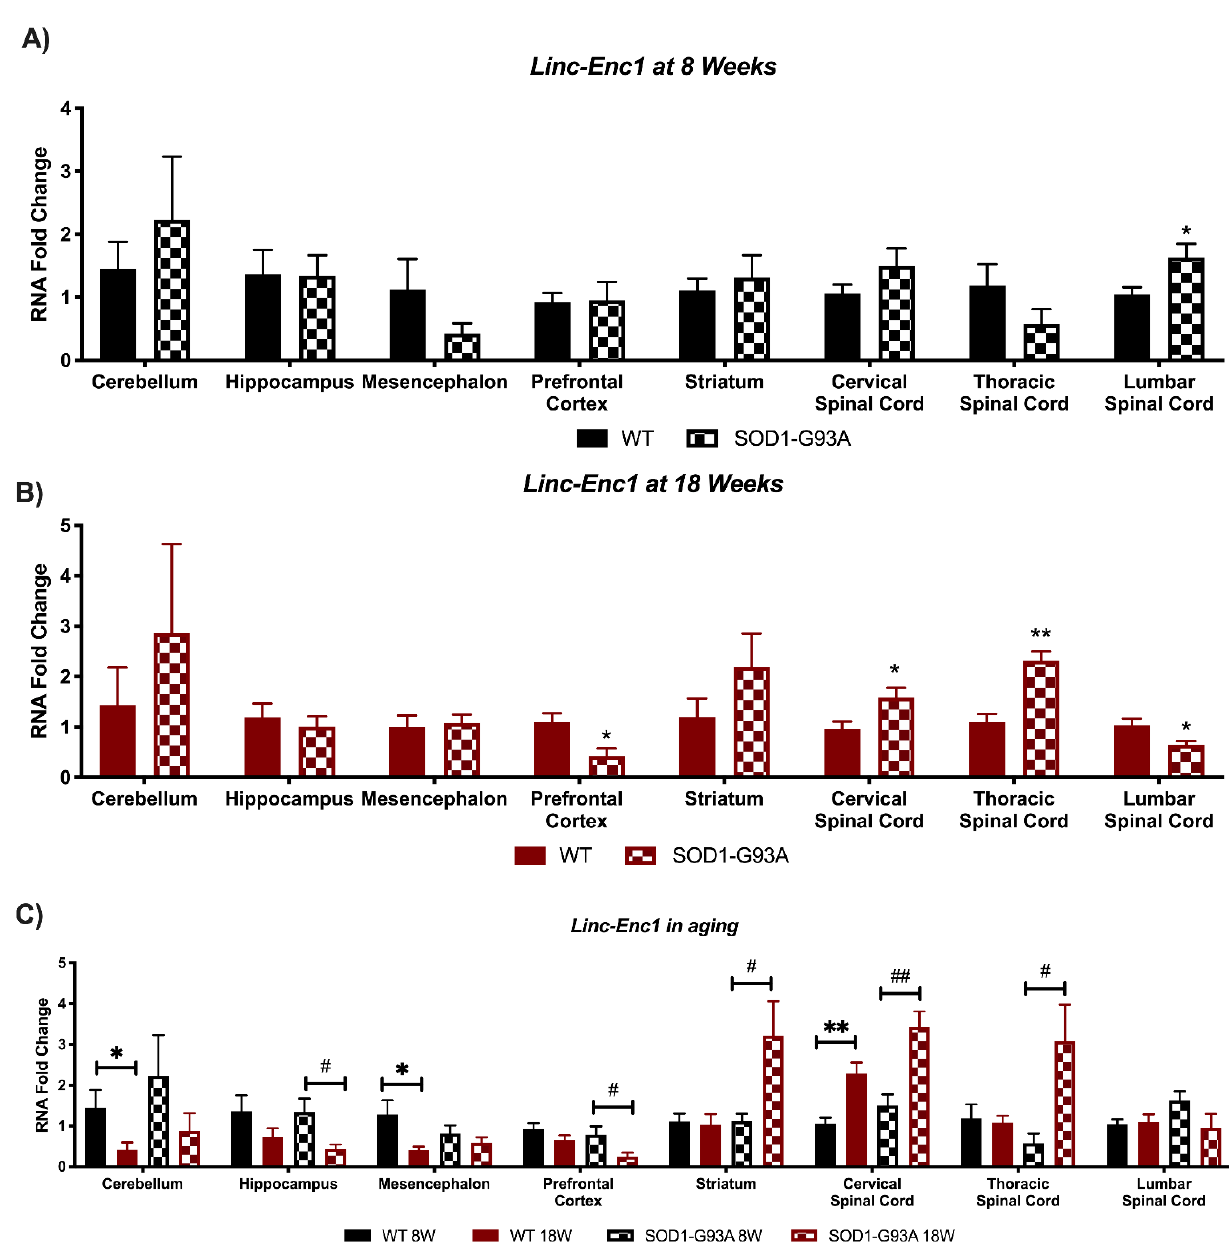
Figure 7. Analysis of Linc-Enc1 expression shows strong perturbations in SOD1-G93A mice. RNAs expression levels were evaluated by Real Time-PCR in the different conditions. Data are expressed as mean ± SEM. ( A ) Linc-Enc1 expression in 8 weeks old WT ( n = 6) mice versus 8 weeks old SOD1-G93A mice ( n = 6). * p < 0.05 vs. WT. ( B ) Linc-Enc1 expression in 18 weeks old WT ( n = 6) mice versus 8 weeks old SOD1-G93A mice ( n = 6). * p < 0.05, ** p < 0.01 vs. WT. ( C ) Linc-Enc1 expression in 8 weeks old WT mice versus 18 weeks old WT ( n = 6) and 8 weeks old SOD1-G93A mice versus 18 weeks old SOD1-G93A mice ( n = 6). * p < 0.05, ** p < 0.01 vs. WT 8W, # p < 0.05, ## p < 0.01 vs. SOD1-G93A 8W.